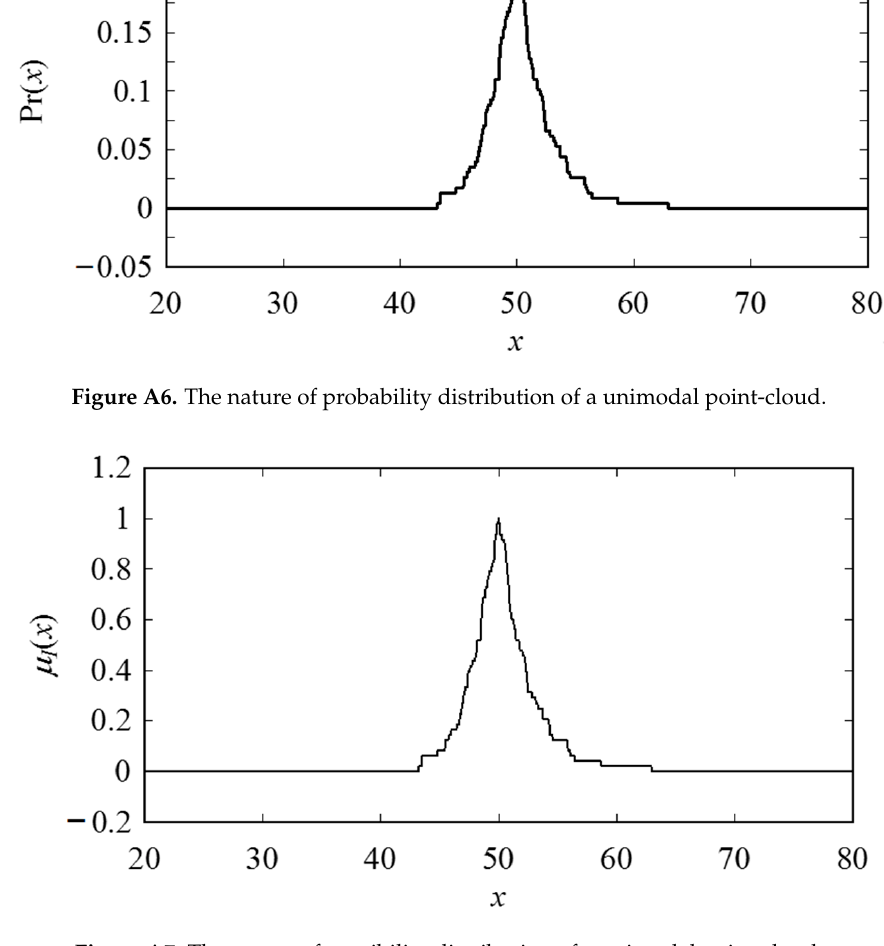
Figure A7. The nature of possibility distribution of a unimodal point-cloud.